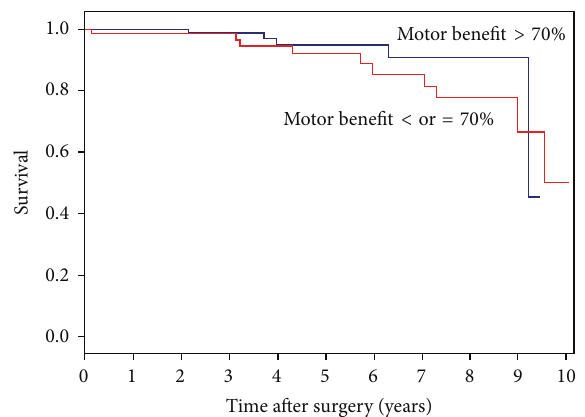
Figure 2: Survival of PD patients by motor benefit following DBS. Cox regression indicates no statistical difference between groups.